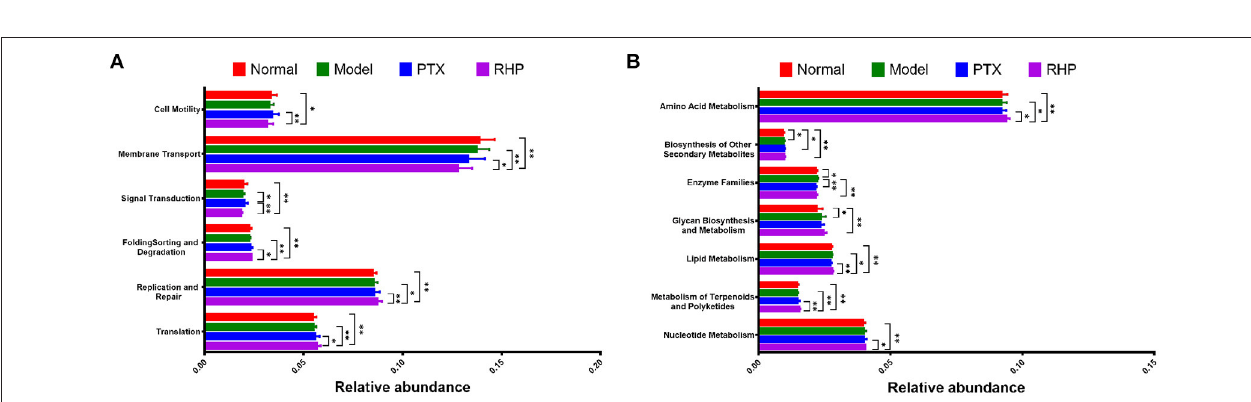
FIGURE 6 | Lefse analysis and metabolic pathway enrichment analysis for microbiota in the cecum content. (A) Overall exhibition of Lefse analysis by cladogram. (B) LDA scores results of the specific enriched genera in each group. (C) Spearman analysis of microbiota-metabolite relationship presented by heatmap. * p < 0.05.